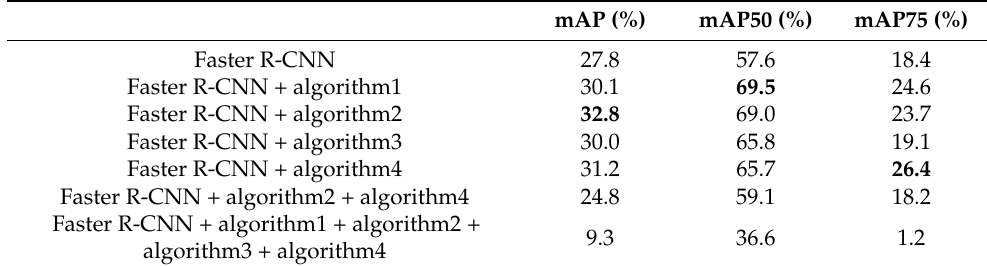
Table 2. Comparison of mAPs for different